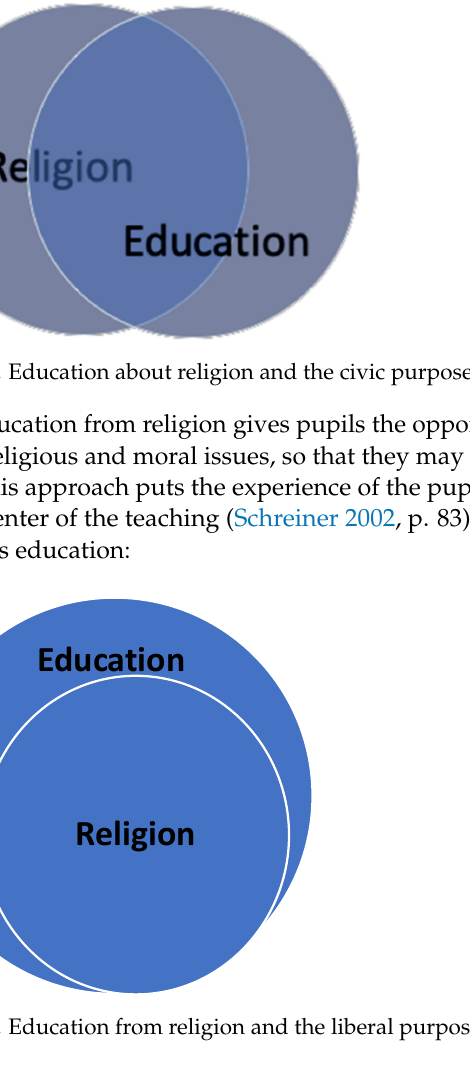
Figure 1. Education into religion and the communitarian purpose of religious.